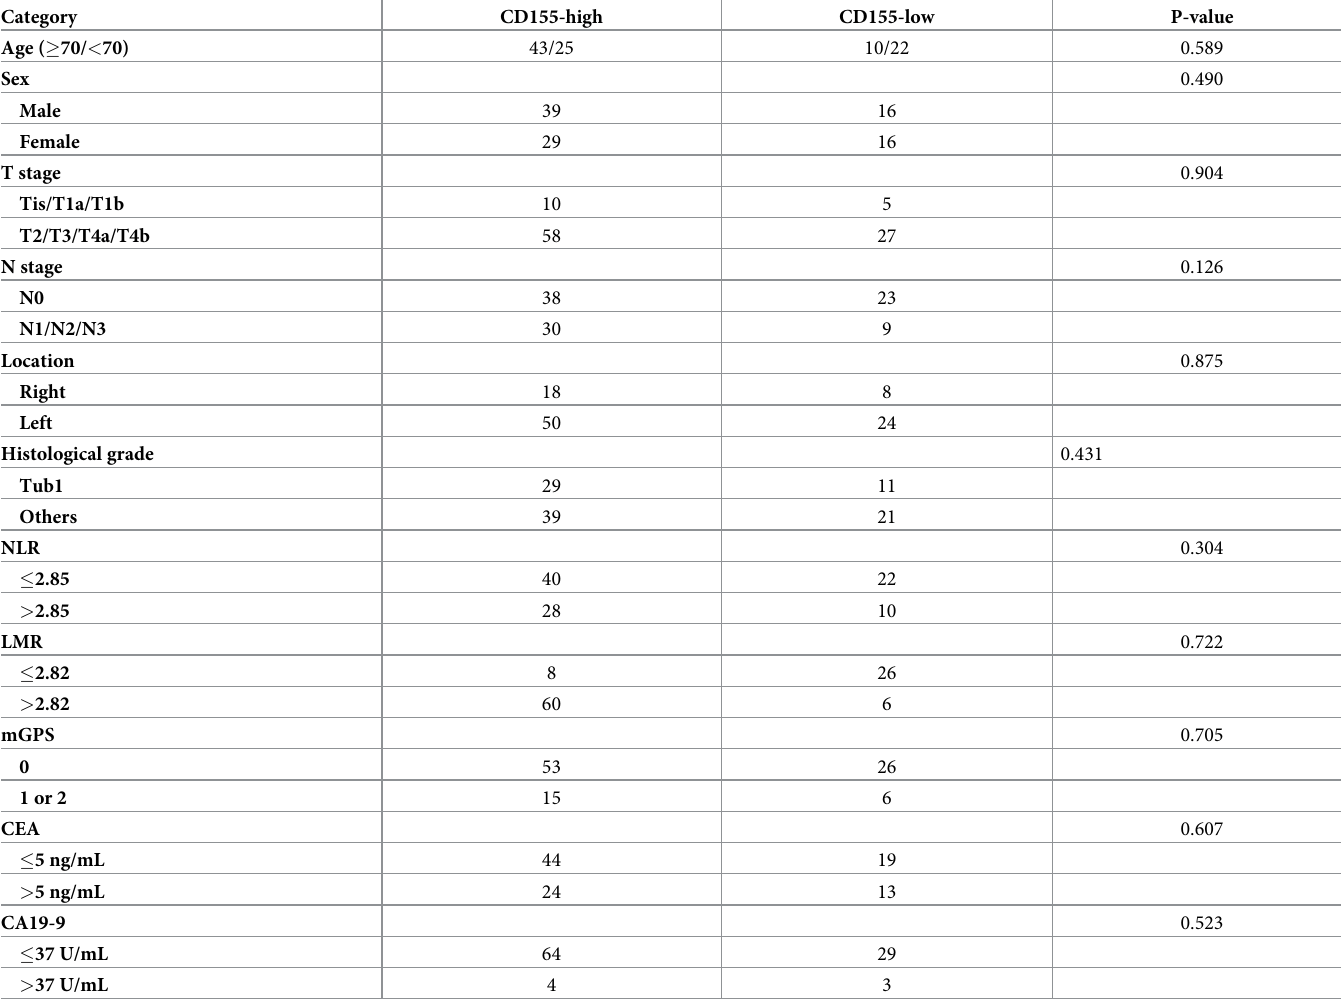
Table 1. Patient background and CD155 expression